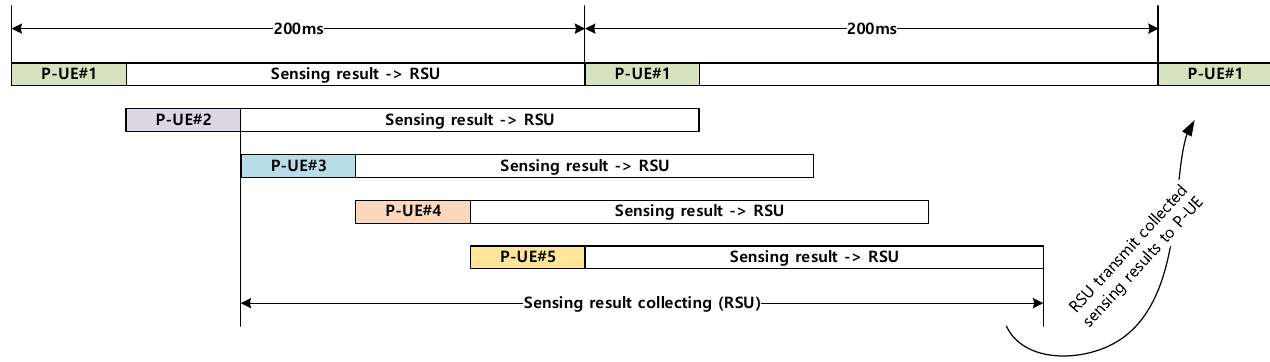
Figure 6. Timing diagram for exchanging the sensing results between RSU and P-UEs. Figure 7 illustrates how the partial sensing windows should be realigned as a P-UE (or P-UEs) exits the RSU coverage. P-UE#2 and P-UE#1 exit the RSU coverage from an initial state wherein the three P-UEs have been aligned, as shown at the top in Figure 7. As P-UE#2, whose partial sensing window has a time slot of 40–80 ms, exits the coverage, the partial sensing window of P-UE#3 occupies this time slot. Similarly, as P-UE#1, which occupied 0–40 ms, exits, P-UE#3 takes this time slot for partial sensing.